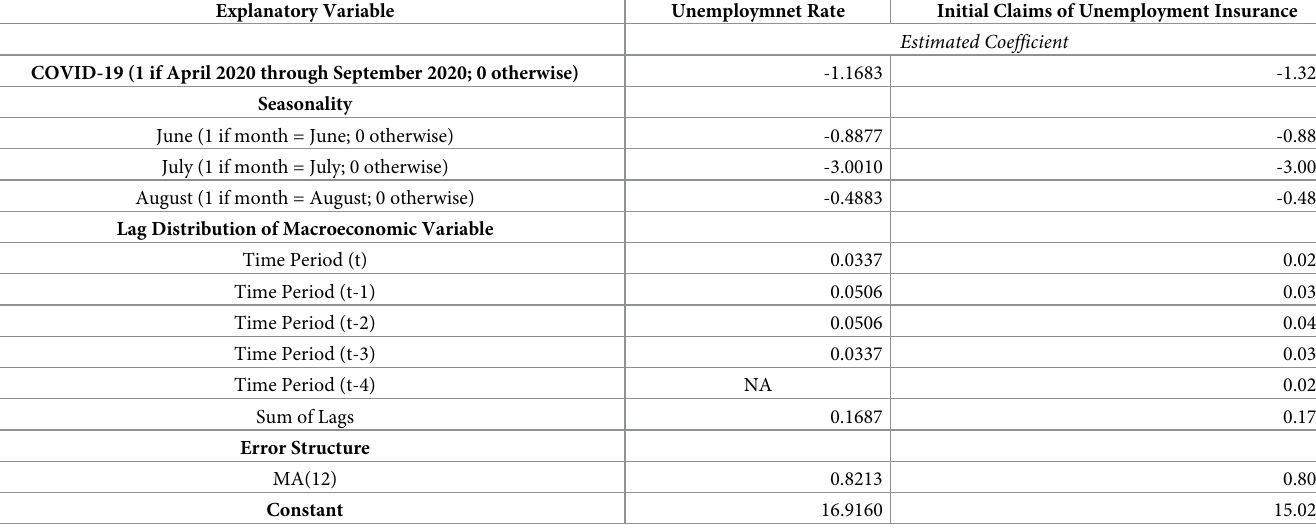
Table 7. Estimated econometric models associated with NSLP participation, October 1999 to September 2020. Explanatory Variable Unemploymnet Rate